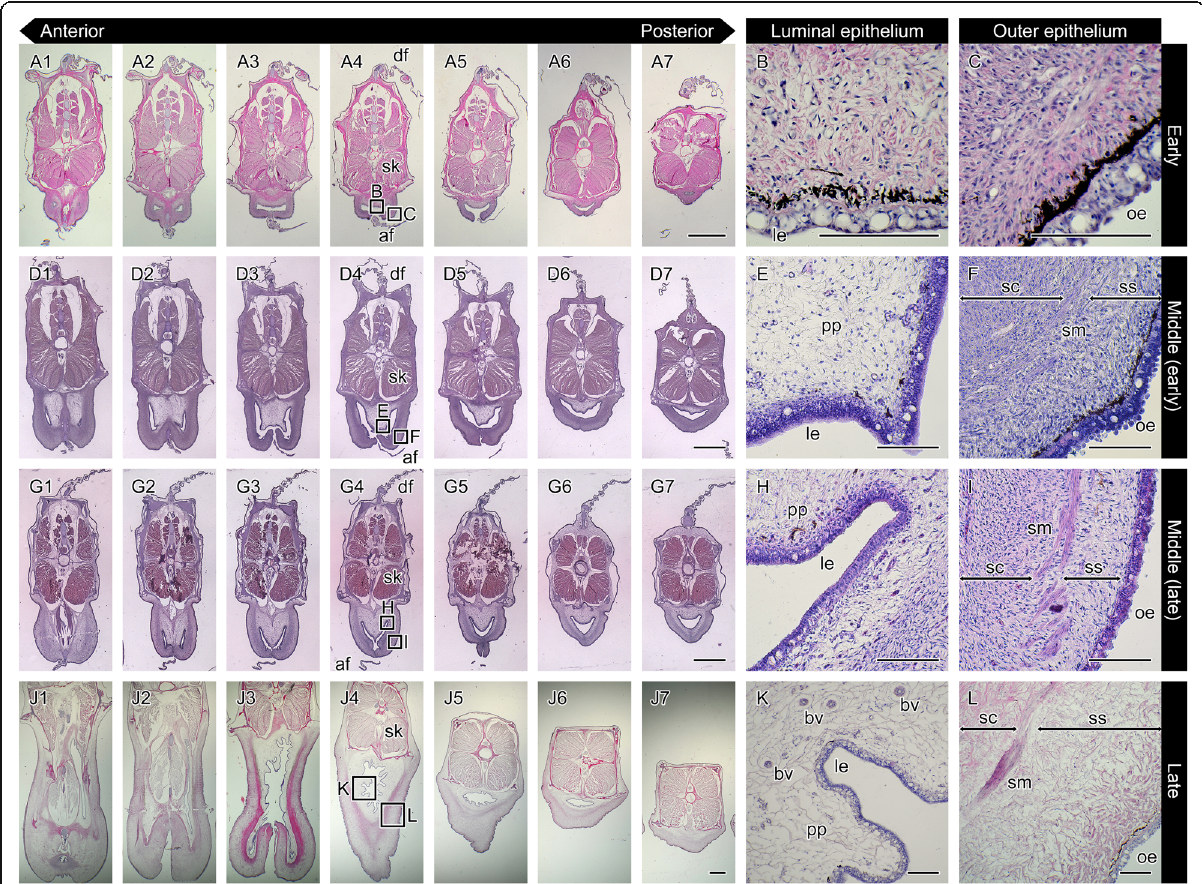
Fig. 5 Hematoxylin and eosin stain of serial sections throughout development of the seahorse brood pouch. Serial sections of the body: at the early stage of pouch development showing the I-shaped seam line ( a 1 – 7; the same individual as in Fig. 3 e ); in the early period of the middle stage ( d 1 – 7), and the latter period of the middle stage ( g 1 – 7); and at the late stage ( j 1 – 7). The section views are from the anterior (1) to posterior (7). The lettered boxes in a 4, d 4, g 4, and j 4 indicate sites of high magnification of the luminal epithelium ( b , e , h , k ) and outer epithelium ( c , f , i , l ). af, anal fin; bv, blood vessel; df, dorsal fin; le, luminal epithelium; oe, outer epithelium; pp, pseudoplacenta; sc, stratum compactum; sk, skeletal muscle; sm, smooth muscle; ss, stratum spongiosum. Scale bars: a , d , g , j = 1 mm; b , c , e , f , h , i , k , l = 100 μ m. These photographs were taken using four individuals: one